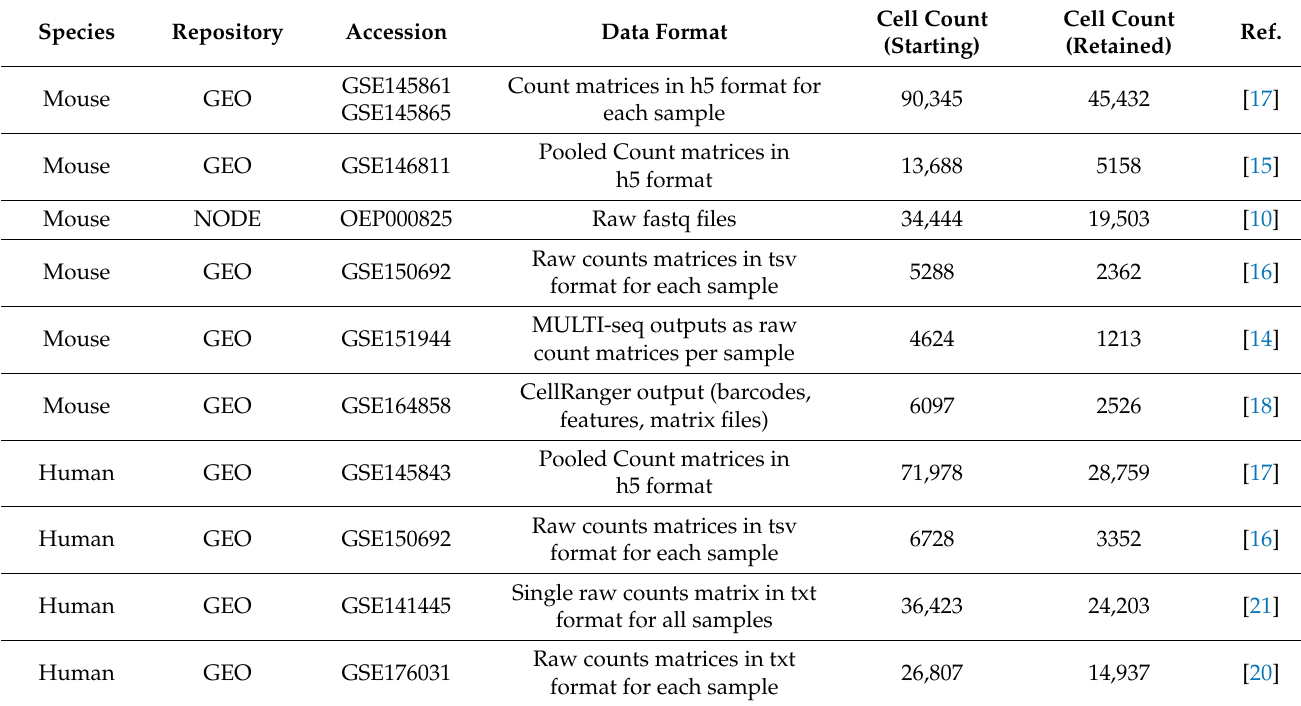
Table 1. References of scRNA-seq datasets re-analyzed in this